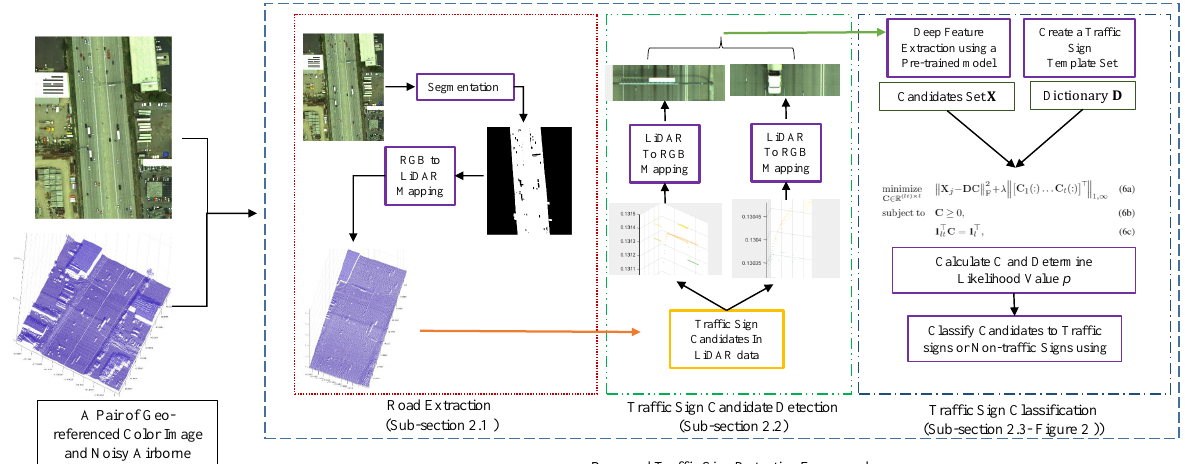
Figure 1. The overview of the proposed